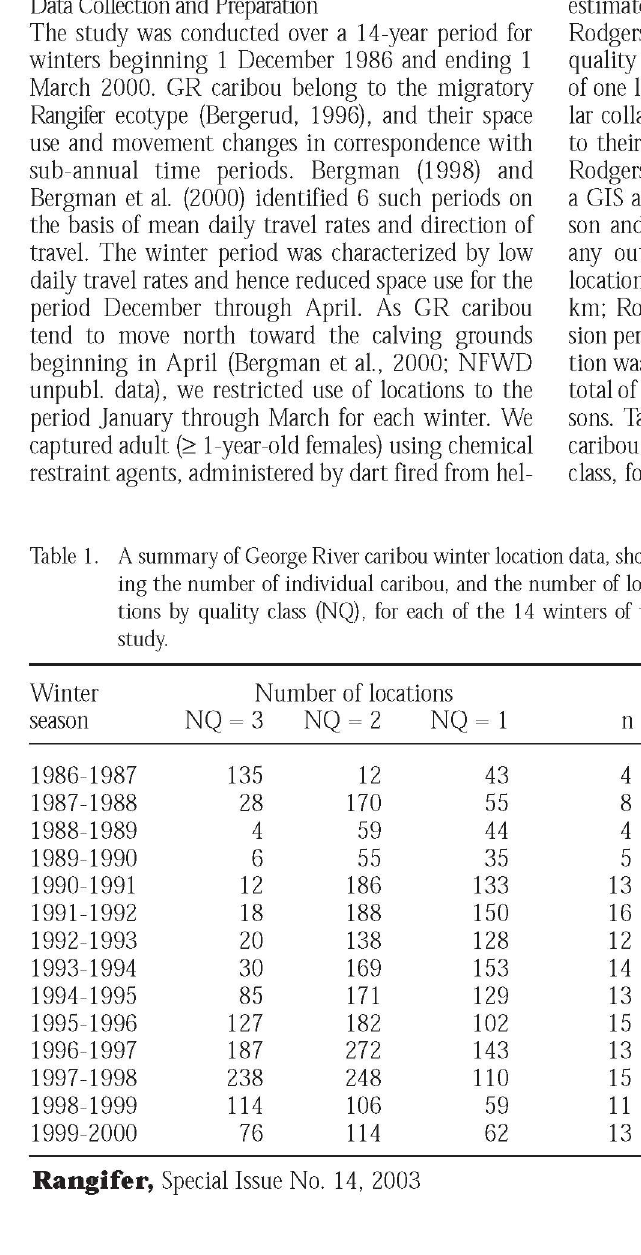
Table 1. A summary of George River caribou winter location data, show¬ ing the number of individual caribou, and the number of loca¬ tions by quality class (NQ), for each of the 14 winters of the